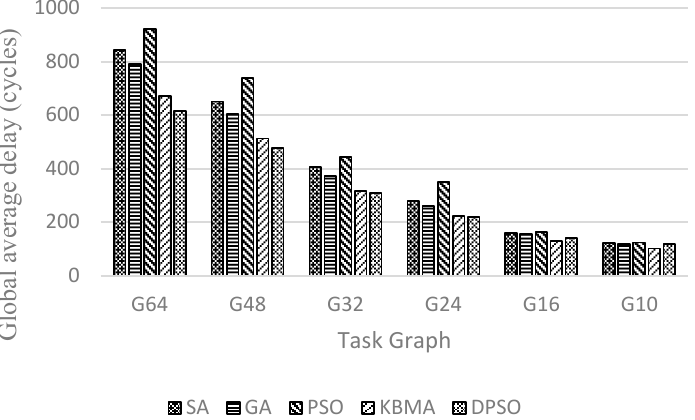
Figure 7. Communication delay at different sizes of random task graphs on 4 × 4 × 4 3D mesh structure.